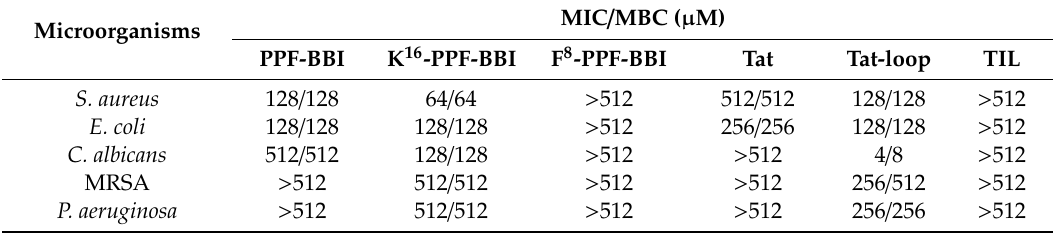
Table 3. The minimal inhibitory concentrations (µM) and minimal bactericide concentrations (µM) of PPF-BBI and the synthetic analogue peptides against microorganisms.